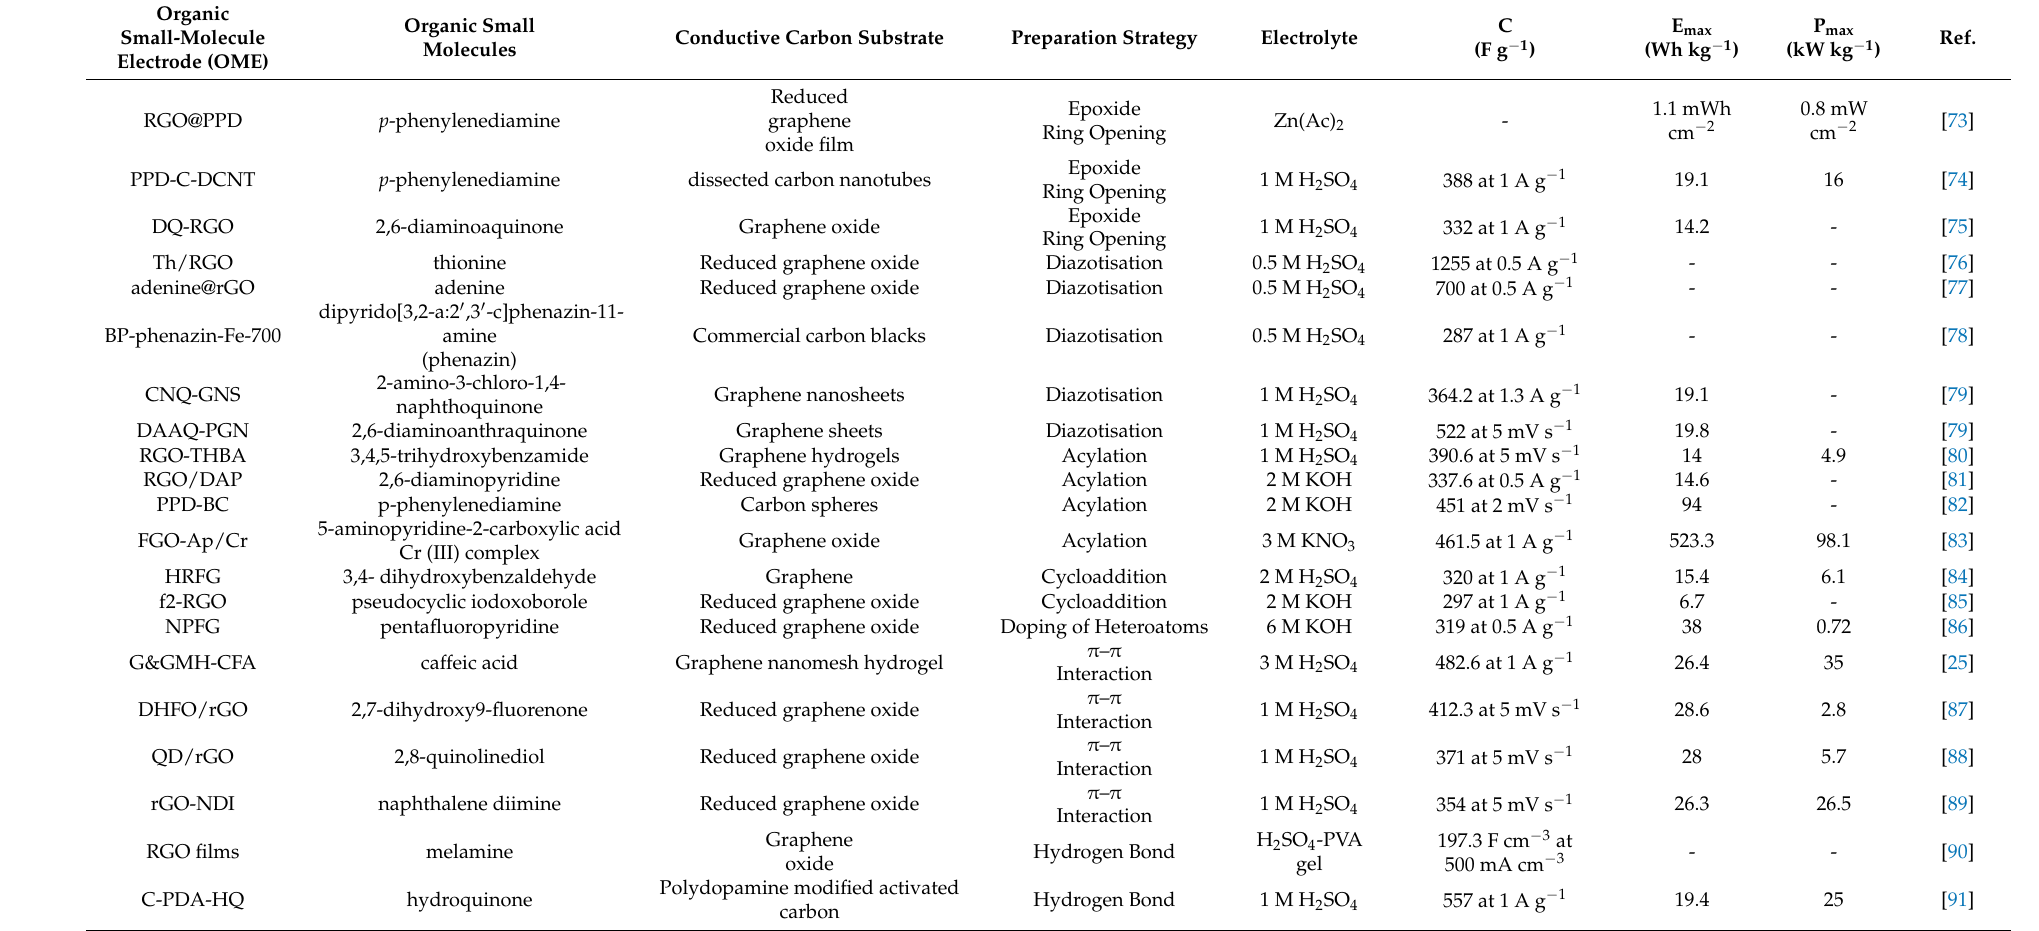
Table 2. Capacitance performance of OMEs prepared with different preparation